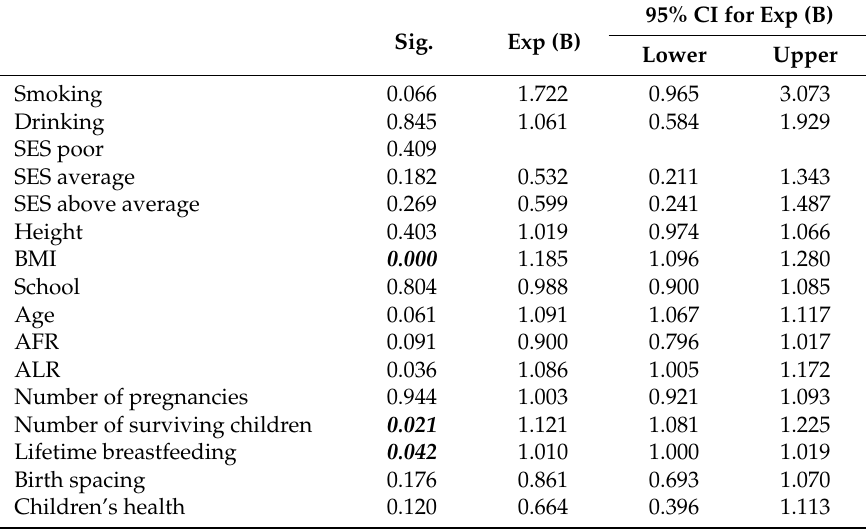
Table 3. Variables in the